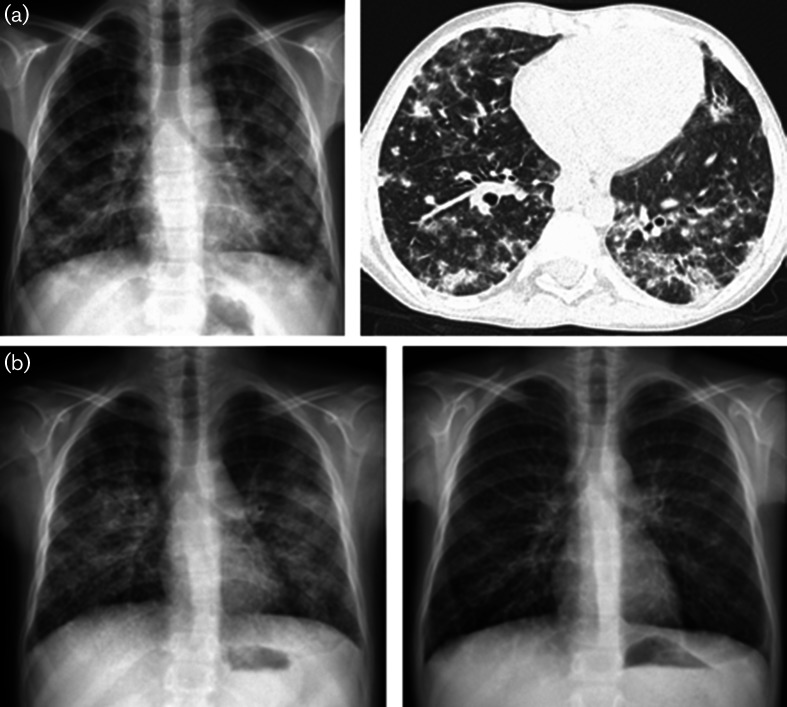
(a) Chest X-ray and thorax CT of Patient 2 (at 10 years of age): bilateral patchy and nodular infiltrations with indistinct margins and coarse septal thickenings. (b) Chest X-ray before and after abatacept therapy (6 months): bilateral hazy parenchymal infiltrations at the start of abatacept therapy. There was almost complete resolution of parenchymal infiltrations with only residual coarse reticular interstitial markings.